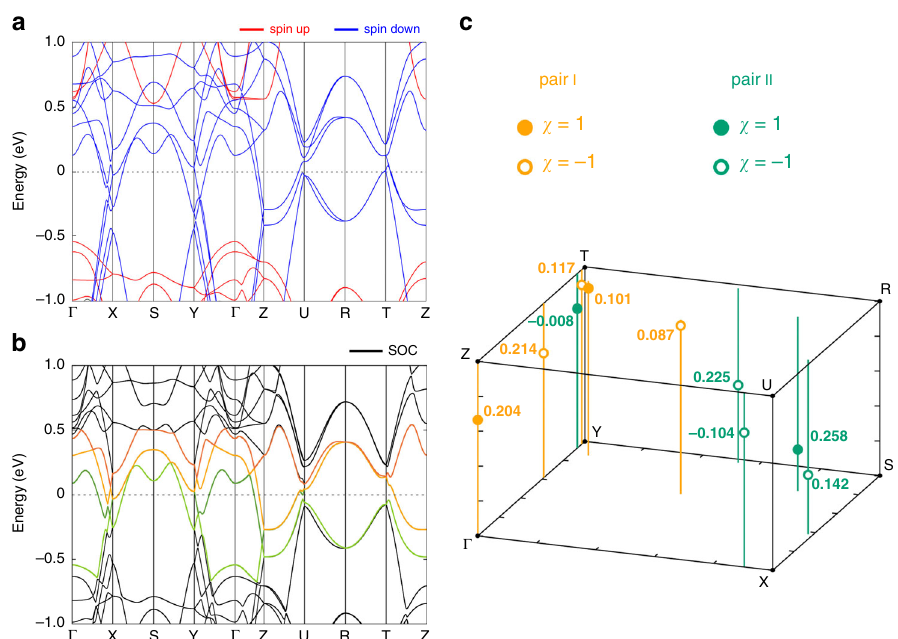
Fig. 5 Predicted Weyl points in the orthorhombic Pbnm ( D 2h ) phase of SrRuO 3 . a Band structure for the ferromagnetic ground state without spin-orbit coupling as obtained from GGA + U calculations with U = 2.6 eV and J = 0.6 eV. b Band structure for the ferromagnetic state with spin – orbit coupling and the magnetization along the orthorhombic c -axis obtained from GGA + U + SOC calculations with U = 2.6 eV and J = 0.6 eV. Two pairs of bands I (orange and dark orange bands) and II (green and dark green bands) are selected for calculating the corresponding chirality χ at each band crossing point. c Positions of the Weyl points in the irreducible part of the Brillouin zone calculated for two pairs of bands I (orange fi lled and open circles for χ = 1 and − 1, respectively) and II (green fi lled and open circles for χ = 1 and − 1, respectively). Numbers next to the points indicate their energy distance from the Fermi level ( E − E F , where E F is the Fermi energy) in eV unit. Vertical orange and green lines indicate the in-plane ( Γ – X – S – Y plane) positions of the Weyl points for easy viewing. Note that the orange and dark green bands are degenerate at the border of the Brillouin zone (X – S – Y and Z – U – R – T –